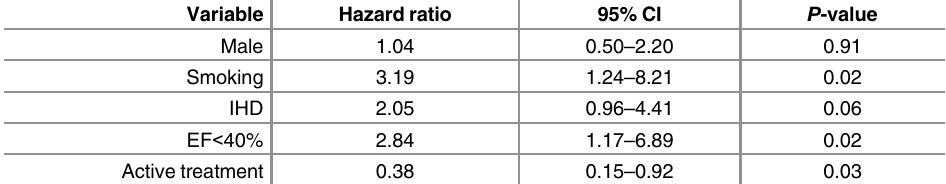
Table 3. Proportional hazard regression analysis of cardiovascular mortality in the study population with a basal selenium level of 65 – 85 μ g/L (mean value) during an intervention time of four